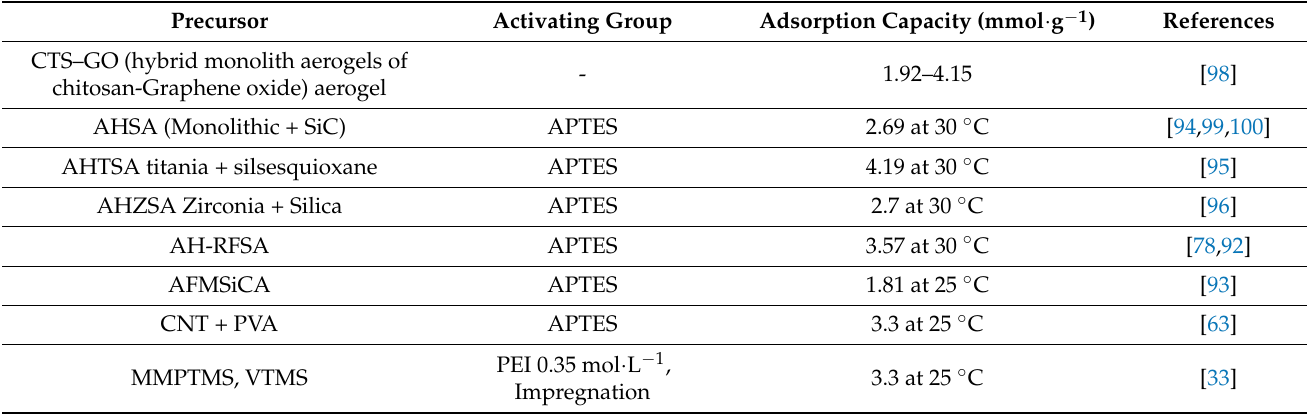
Table 3. CO 2 capture by hybrid